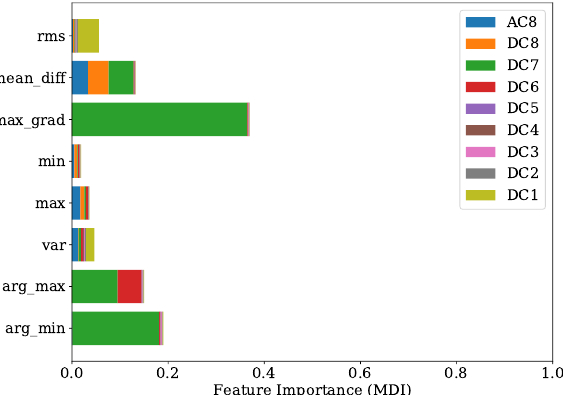
Figure 21. FI of MFB50 regression with regard to training set of engine 1.